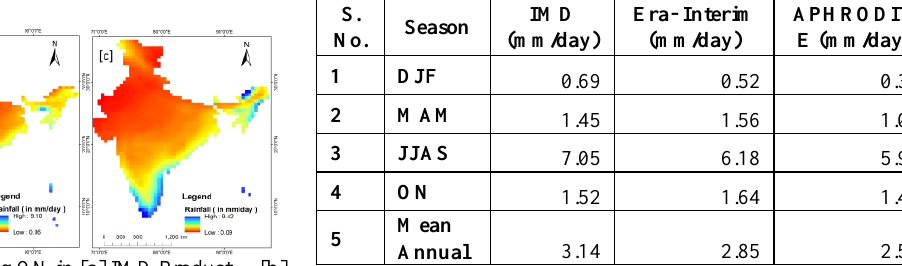
Figure 6. Seasonal rainfall during ON in [a] IMD Product, [b] APHRODITE Product and [c] Era-Interim Product